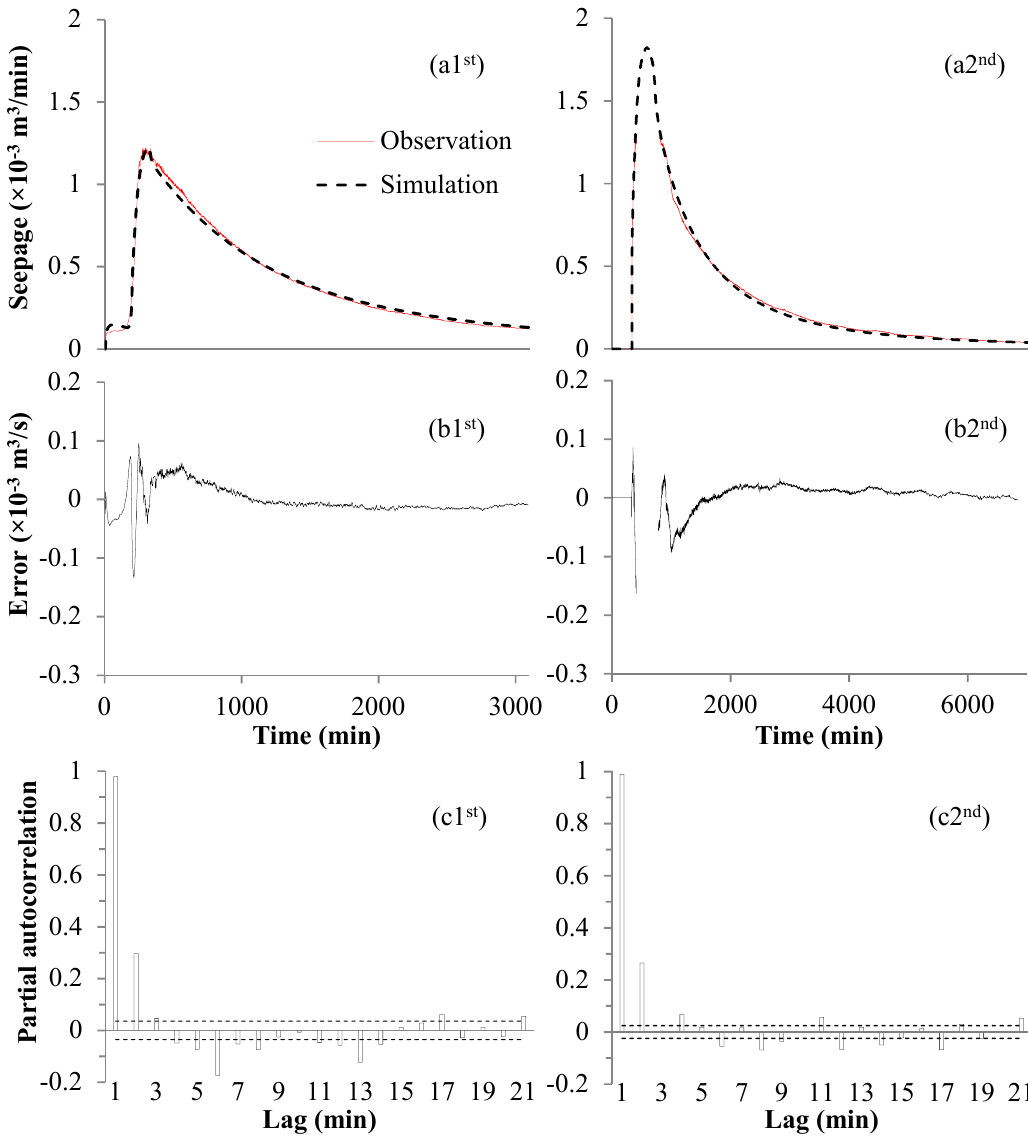
Figure 4. Error analysis for the simulated seepages of the MSE method. ( a ) Comparison between the observed and simulated soil tank seepages. ( b ) Errors between the observed and simulated seepages. ( c ) Partial autocorrelation coefficients of errors with 95% significance levels. Left column is for the first experiment and right column is for the second